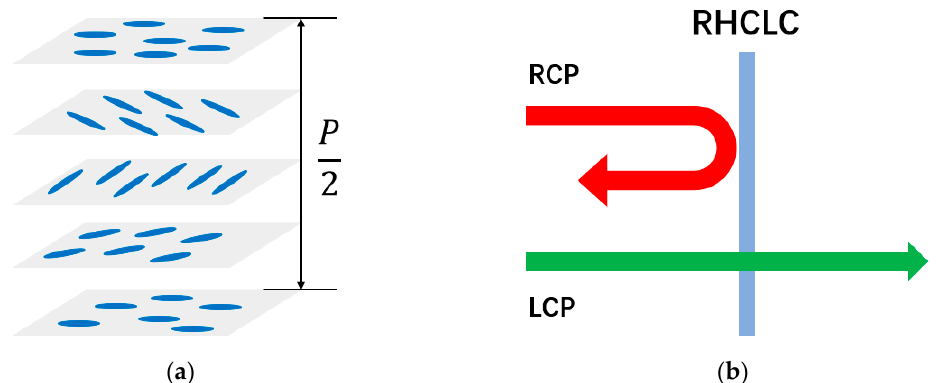
Figure 1. ( a ) Schematic diagram of the director configuration of a CLC; ( b ) Polarization-selective reflectivity of a CLC film.